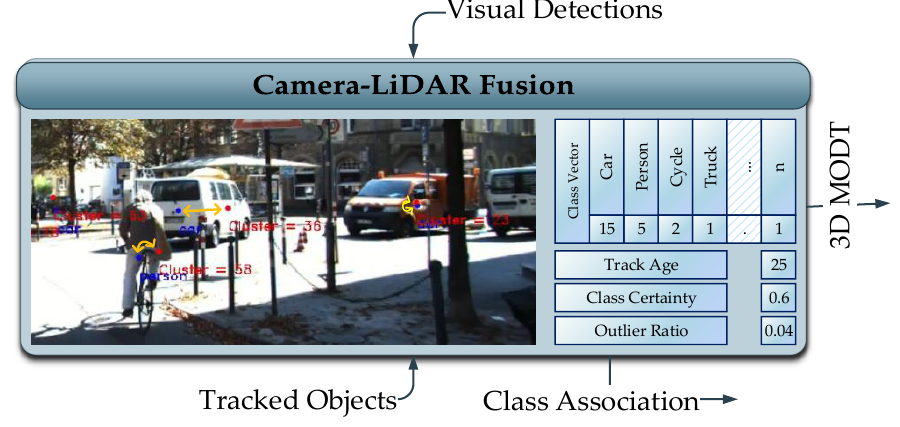
Figure 4. Camera-LiDAR Fusion Module.